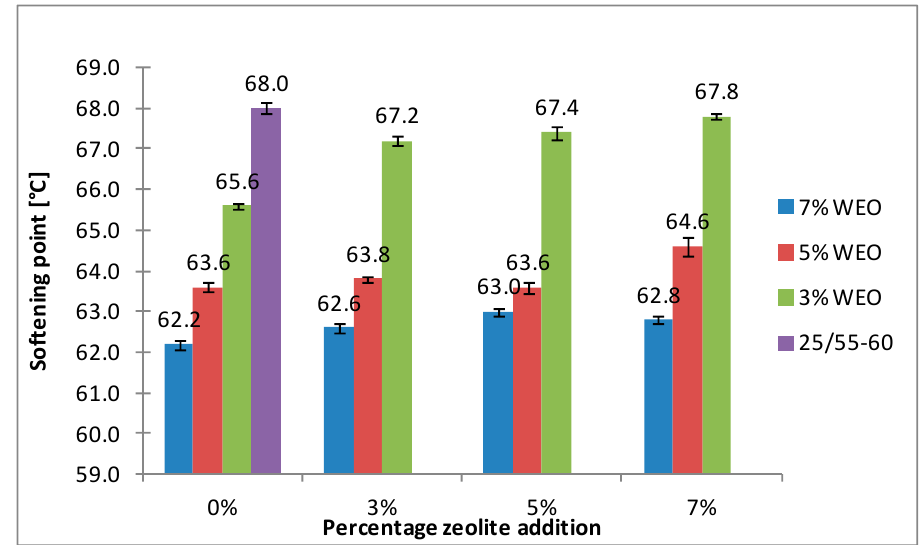
Figure 10. The results of softening point tests for the 25/55-60 asphalt with the addition of WEO and Na-P1 zeolite.